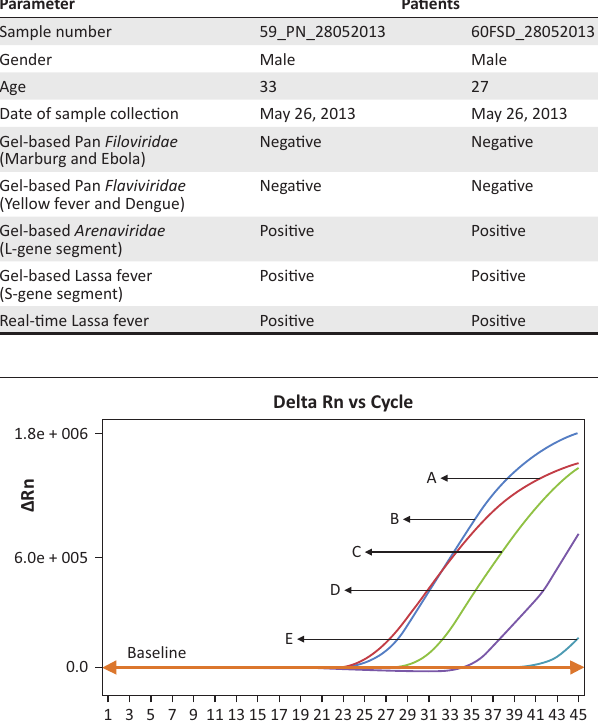
TABLE 3: Summary of suspected patient information and their test results, Ghana, 2013. Parameter